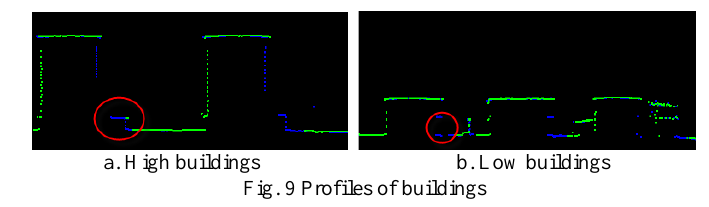
Fig. 9 Profiles of